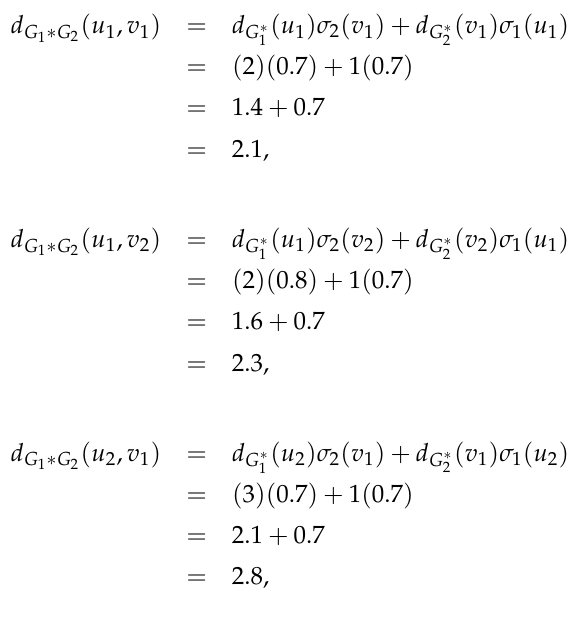
G 2 = ( σ,µ 1 ,µ 2 ,µ 3 ) Figure 10. G 1 ∗ G 2 = ( σ , µ 1 , µ 2 , µ 3 ) ∗